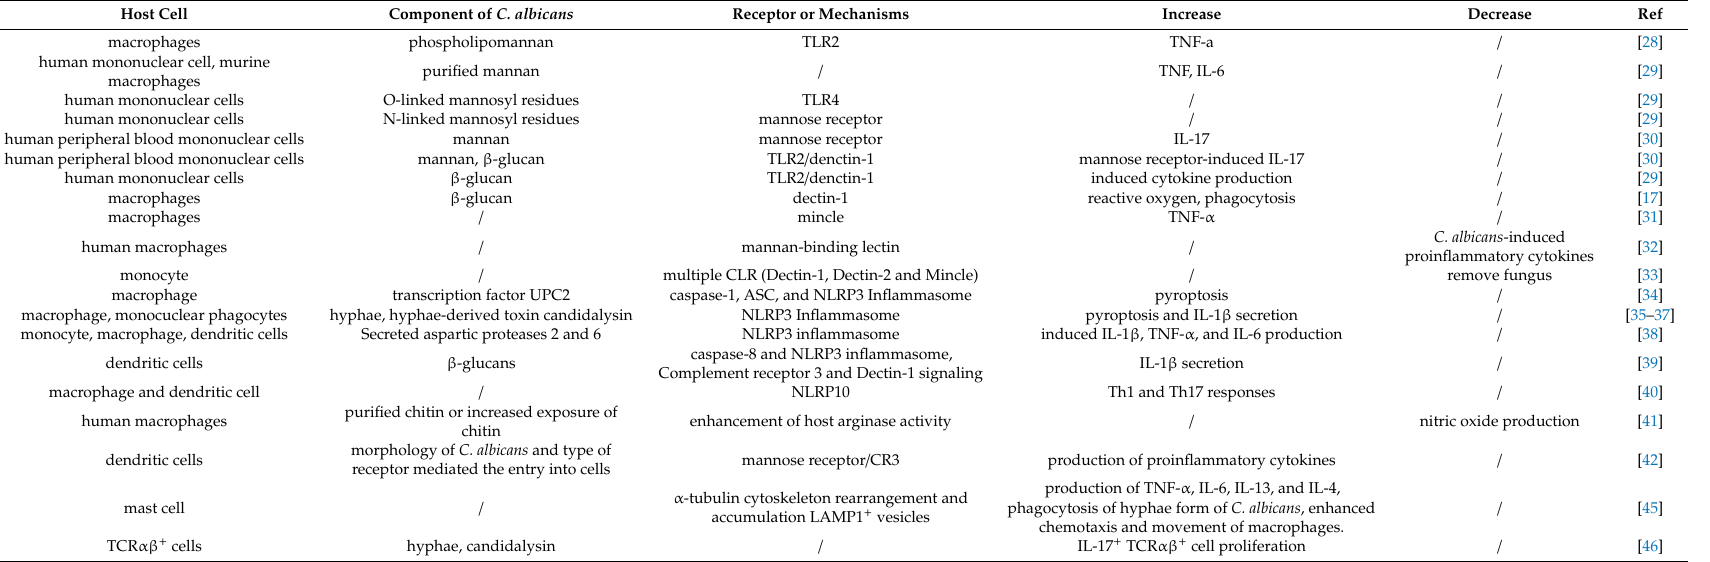
Table 1. Immune cell recognition and response to Candida